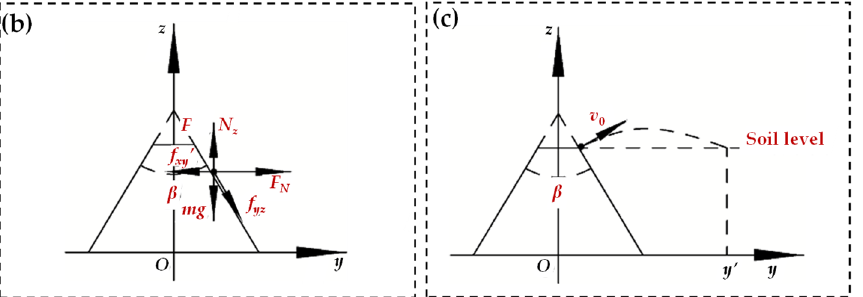
Figure 11. Schematic diagram of disturbed soil surface structure and kinematic analysis of soil particles. ( a ) Schematic diagram of disturbed soil surface structure. ( b ) Force analysis of soil particles. ( c ) Analysis of oblique throwing motion of soil particles.